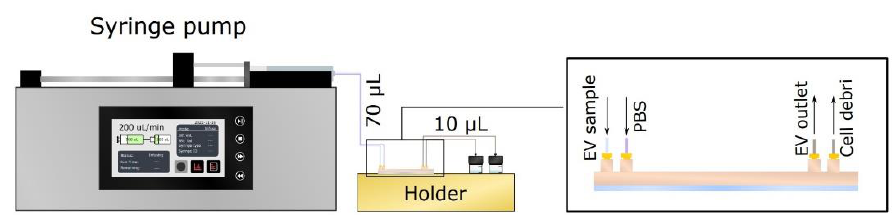
Figure 5. Syringe pump setup used to provide fluid flow for A4F bifurcation EV separation devices.